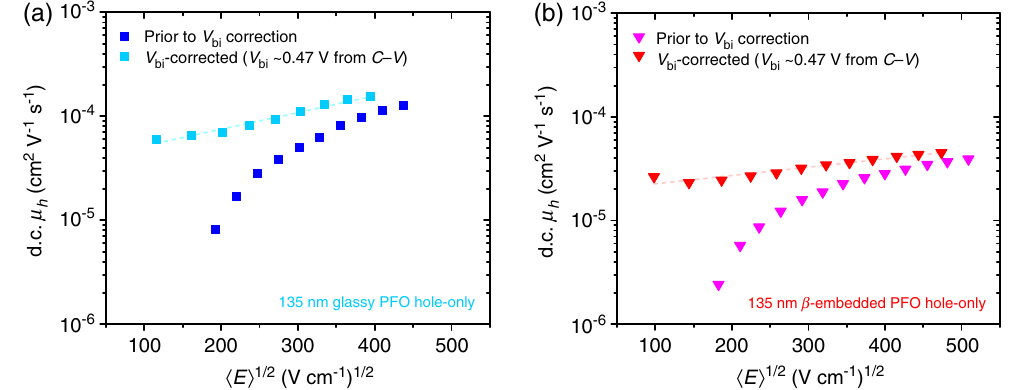
FIG. 25. The V -corrected field-dependent dc hole mobilities for (a) glassy and (b) β -embedded 135-nm HMW PFO hole-only bi devices [the higher mobility sets in both subfigures (a) and (b); same as shown in Fig. 4]. The subfigures also retain dc μ built-in voltage correction (the two lower mobility